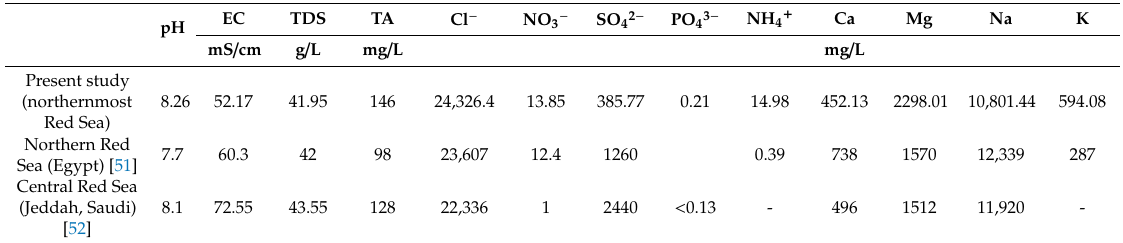
Table 3. Comparison of water quality parameters in di ff erent regions of the Red Sea and GoA.